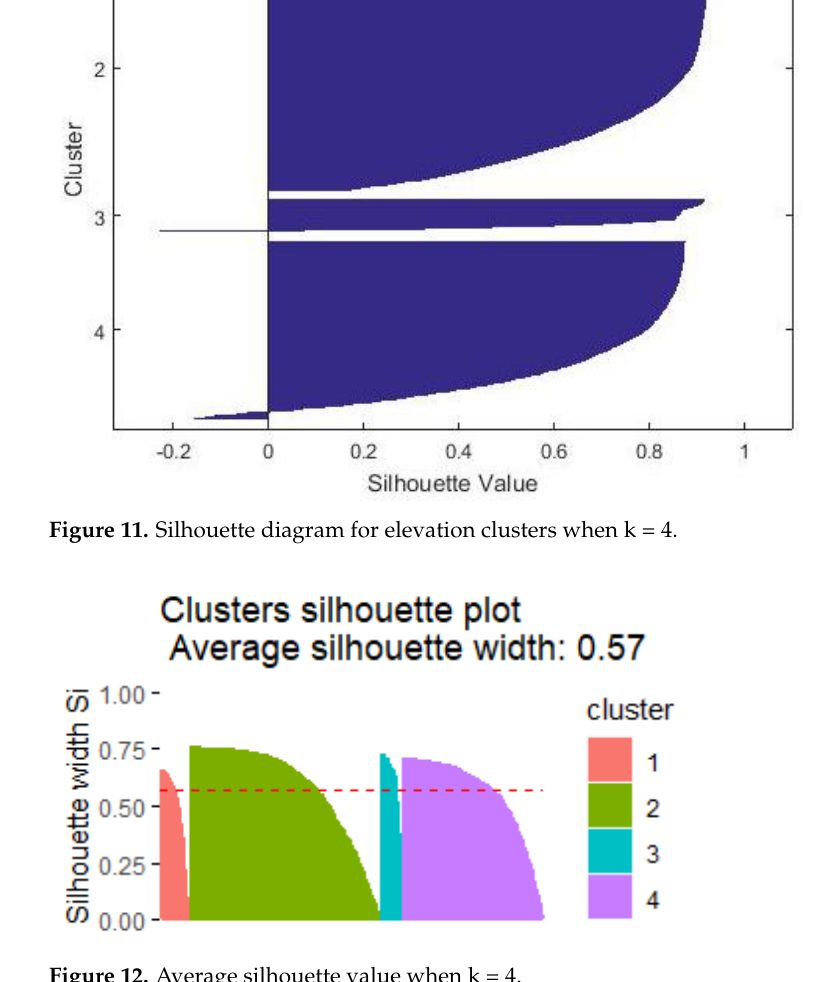
Figure 12. Average silhouette value when k =